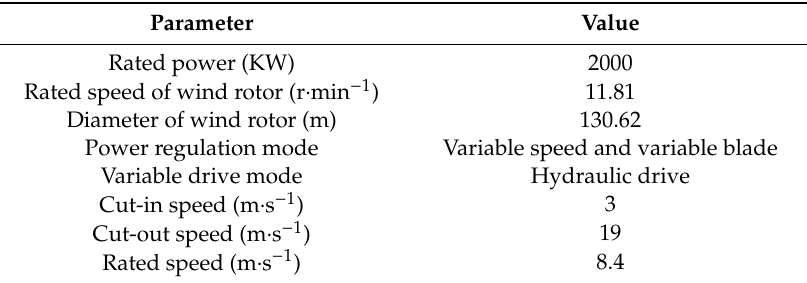
Table 3. Wind turbine